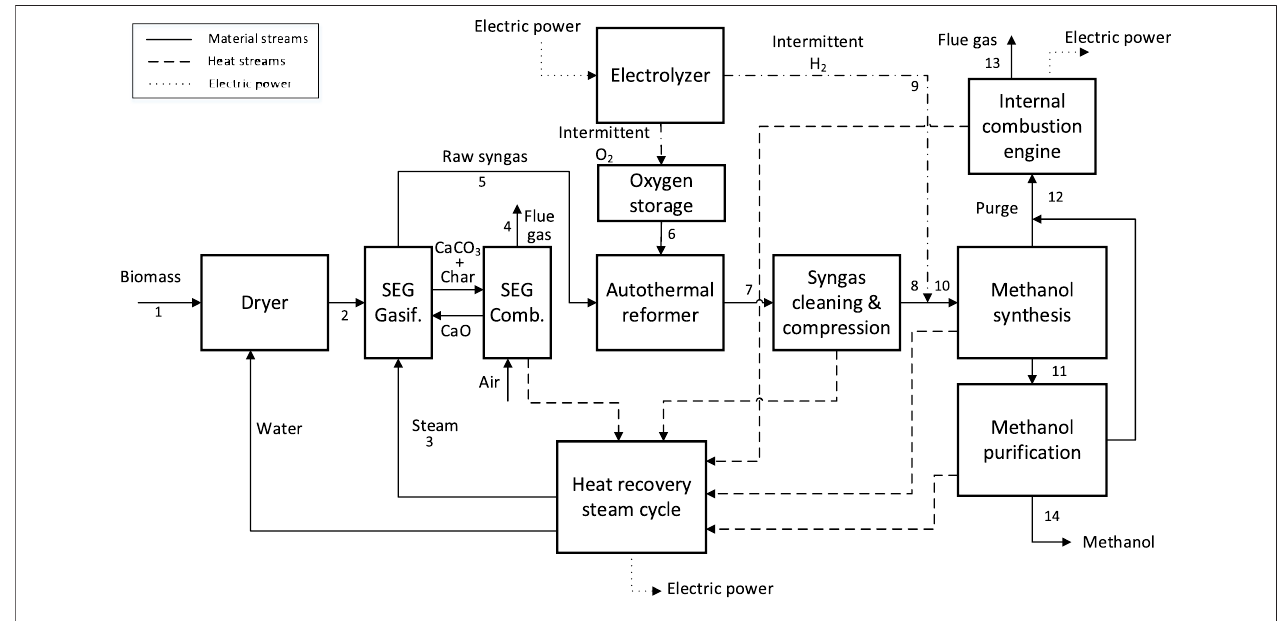
FIGURE 3 | Block diagram of the SEG-based power and biomass-to-methanol plant.